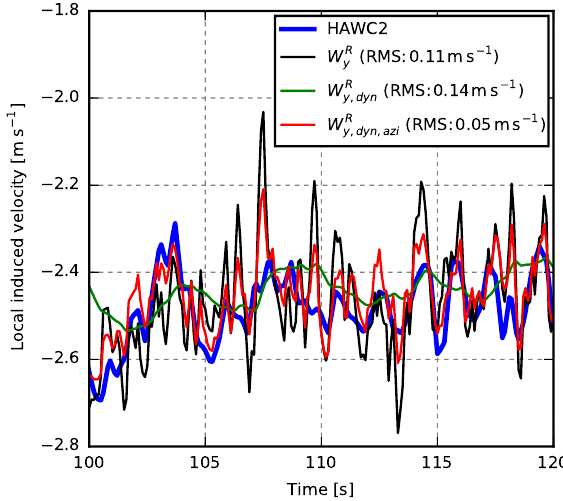
Figure 4. Local induced axial velocity calculated using HAWC2 and the current method in three configurations: W without the dy- namic inflow model ( W R y ), with the dynamic inflow model applied to the rotating measurements ( W R ), and with the dynamic in- y, dyn flow model applied to the low-frequency signals of fixed azimuthal positions ( W R ). y, dyn,azi